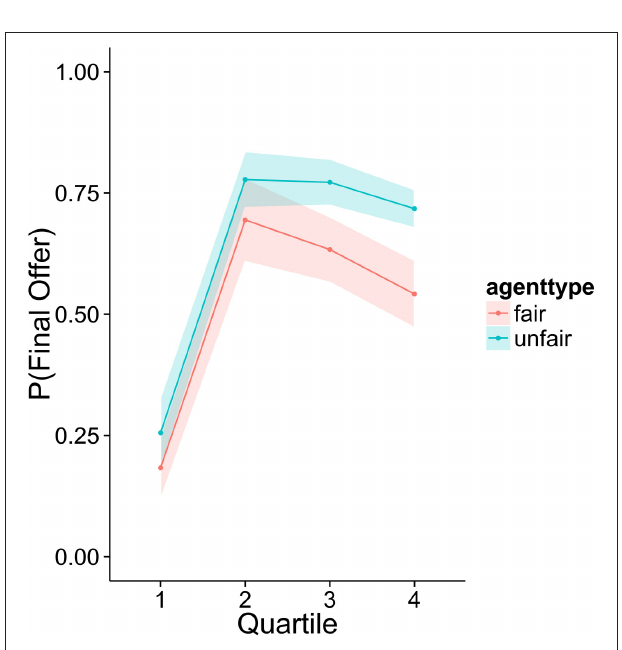
FIGURE 4 | Average probability of using the final offer option as a function of agent and